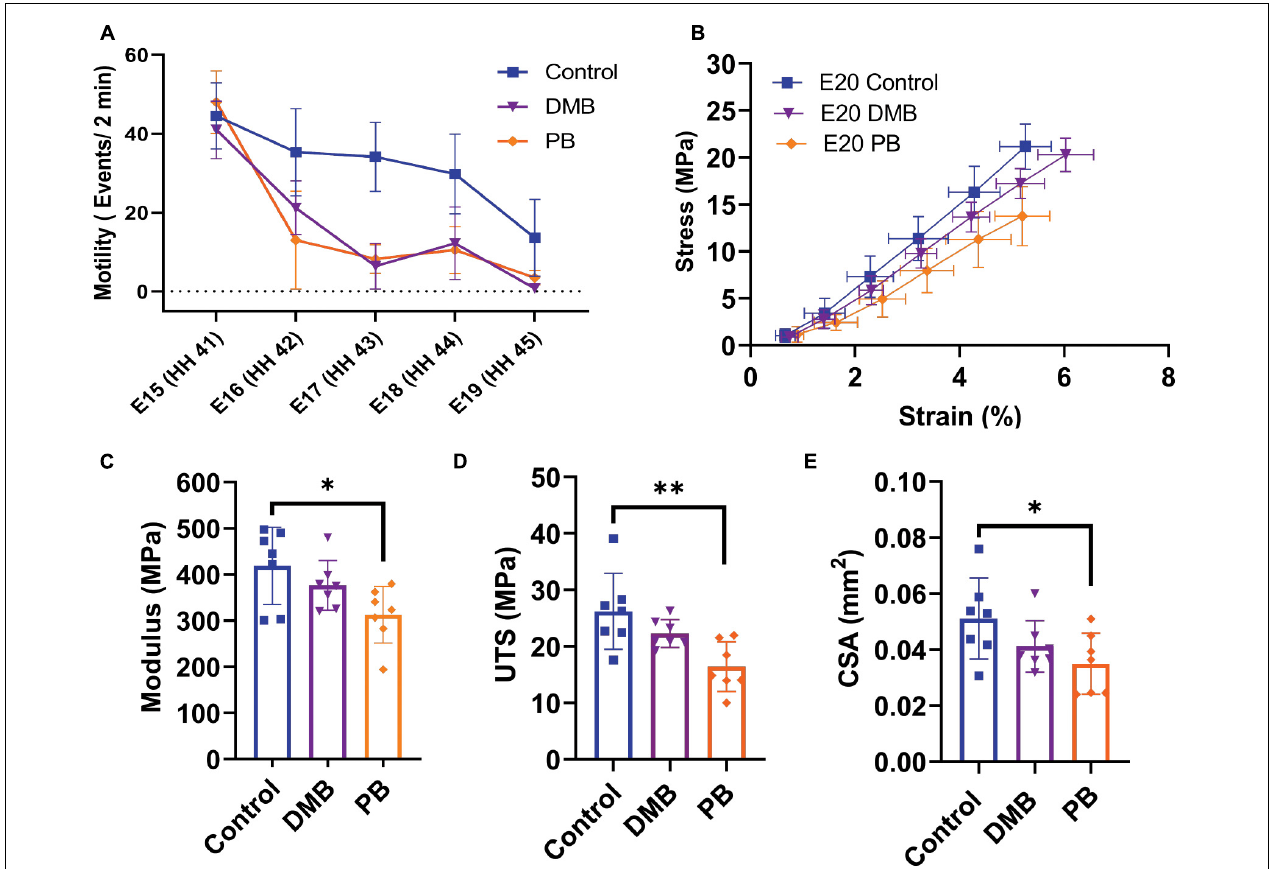
FIGURE 5 | Muscle paralysis and its effect on the macroscale mechanical properties of the flexor digitorum brevis (FDB) digit II tendon during development. (A) Paralysis treatments and saline control were conducted from E15 (HH41) – E19 (HH45). Significant decrease in motility observed under rigid (DMB, p < 0.05) and flaccid (PB, p < 0.05) paralysis. No significant difference in motility counts between the two paralysis methods. (B) Equilibrium stress vs. applied strain for E20 (HH46) samples after control ( n = 7), rigid paralysis (DMB, n = 7), and flaccid paralysis (PB, n = 7) treatments. (C) Equilibrium modulus is significantly reduced with flaccid paralysis treatment ( p < 0.05). (D) Significant decrease in ultimate tensile stress (UTS) with flaccid paralysis ( p < 0.01). (E) Cross-sectional area of flexor digitorum brevis (FDB) tendon was observed under flaccid paralysis conditions when measured under confocal microscope ( p < 0.05). Effects on embryonic motility were evaluated using an ANCOVA with Bonferroni post hoc test. Significance for Modulus, UTS, and CSA were evaluated using a one-way ANOVA with post hoc Tukey’s test corrected for multiple comparison. Data represented as mean ± standard deviation ∗ p ≤ 0.05, ∗∗ p ≤